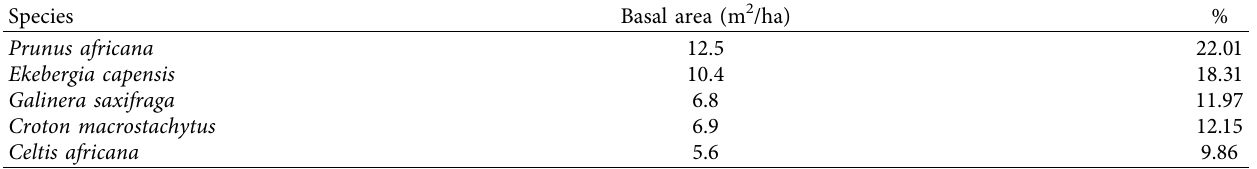
Table 4: Basal area and density distribution of four dominant tree species in the Kenech forest.